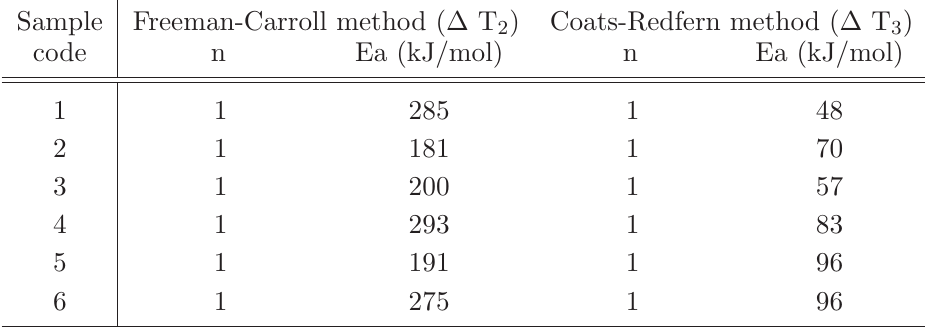
Table 4 Kinetic parameters evaluated from thermogravimetrical